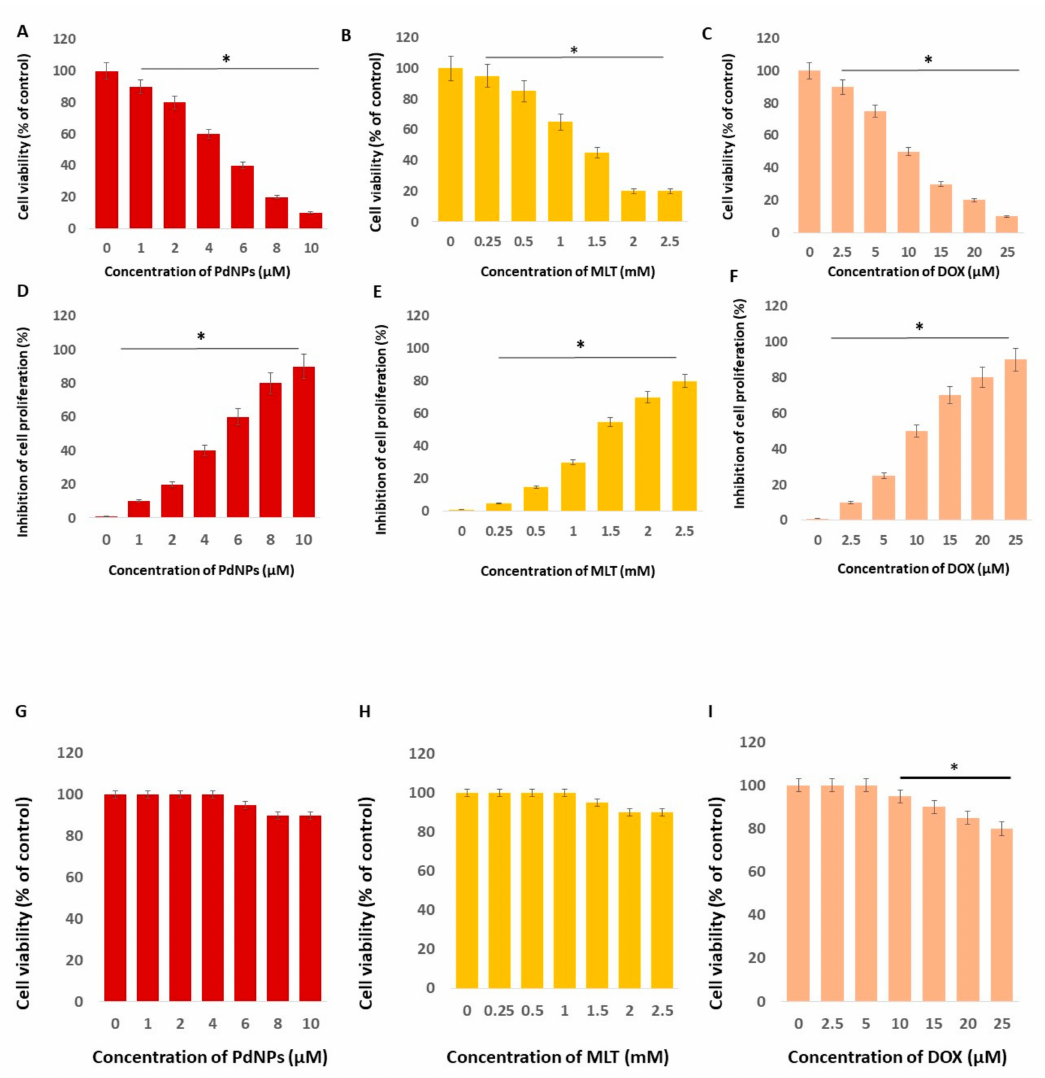
Figure 2. E ff ects of PdNPs, MLT, and DOX on cell viability and proliferation. Cell viability ( A–C ) and cell proliferation ( D–F ) of human adenocarcinoma cells (A549) exposed to di ff erent concentrations of PdNPs, MLT, or DOX for 24 h. Cells were treated with PdNPs at concentrations ranging from 1 to 10 µ M, MLT at concentrations ranging from 0.25 to 2.5 mM, or DOX at concentrations ranging from 2.5 to 25 µ M. Results are shown as the mean ± standard deviation of three independent